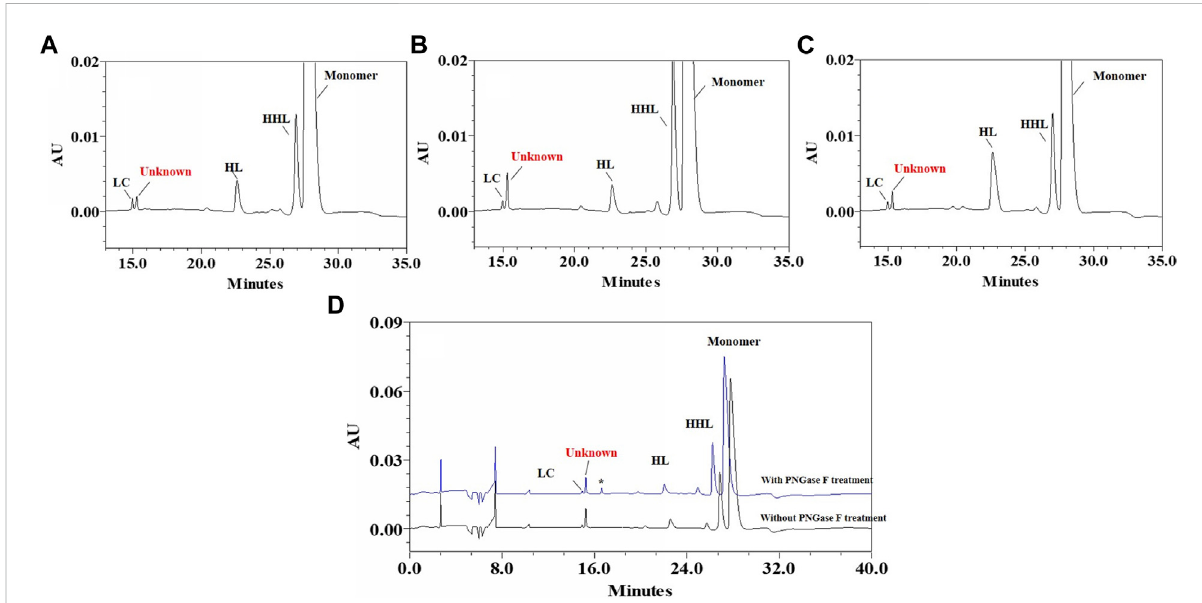
FIGURE 1 Non-reduced CE-SDS e-grams of BsAb cell pools with unknown peak. (A) : Zoomed-in nrCE-SDS e-gram of Cell Pool 1; (B) : Zoomed-in nrCE- SDS e-gram of Cell Pool 2; (C) : Zoomed-in nrCE-SDS e-gram of Cell Pool 3; (D) : nrCE-SDS e-gram of Cell Pool 2 with and without PNGase F treatment; *: